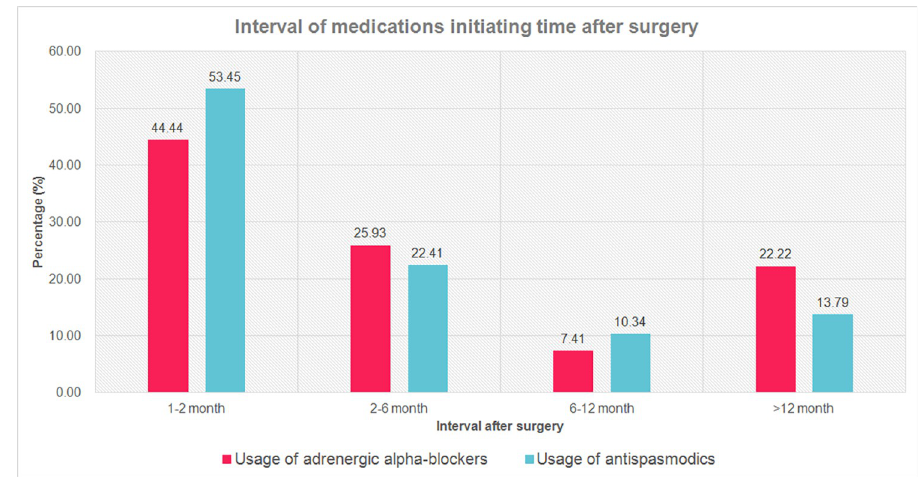
Fig 1. Interval of adrenergic alpha-blockers and medications for OAB initiating time after surgery.